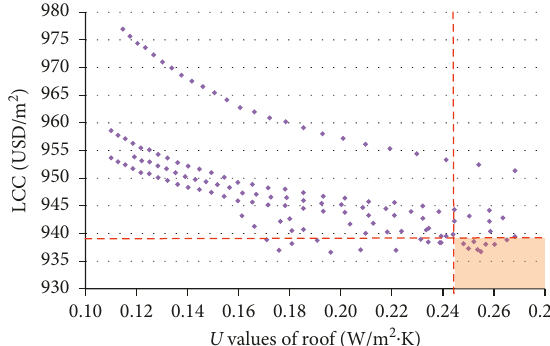
Figure 7: LCC according to the primary energy use for the U values of the